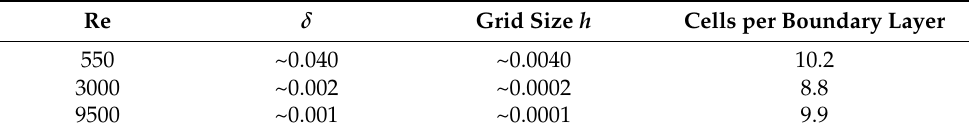
Table 2. Grid sizing